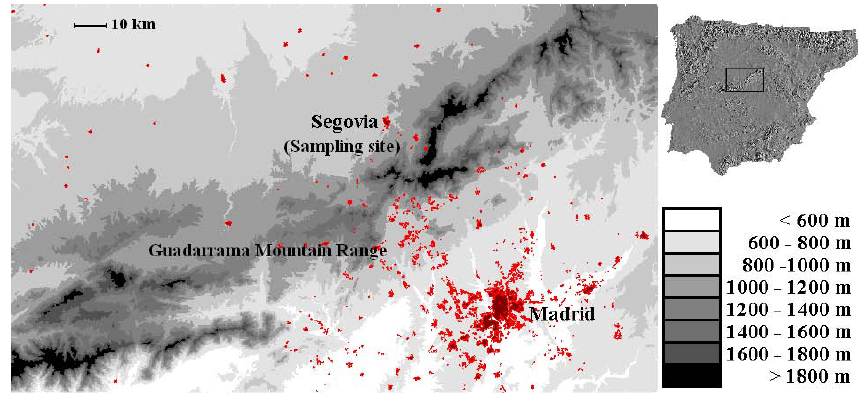
Fig. 1. Topographic map of the sampling site close to the Guadarrama Mountain Range. The domain corresponds to the rectangular area drawn on the Iberian